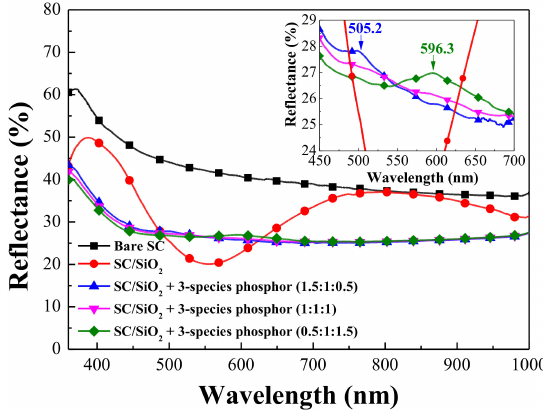
Figure 5. Reflectance spectra of bare silicon solar cell, cell coated with a 250-nm thick SiO 2 layer, and cells coated with a SiO 2 layer that included three species of Eu-doped phosphors in various weight ratios (0.5:1:1.5, or 1:1:1, or 1.5:1:0.5 in wt